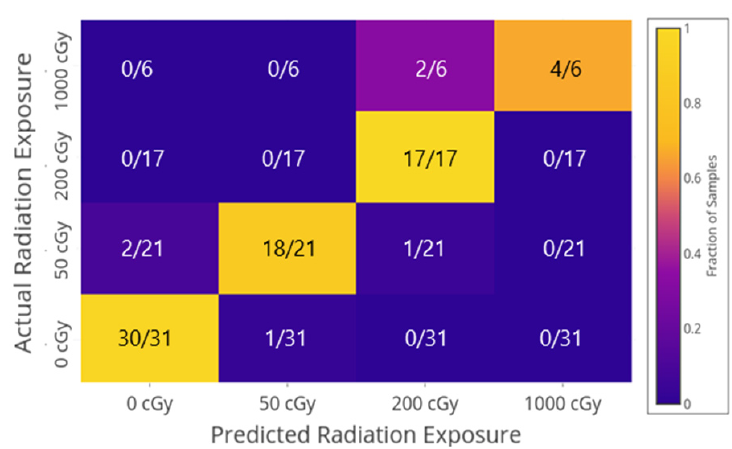
Figure 5. Confusion matrix for murine signature: Phlda3 , Bax , Cdkn1a , Cct3 , Tfam , Pold1 , Cd72 , Cd79b , Ei24 , Galt , Eif2ak4 , Ms4a1 , Ccng1 , Glipr2 , Gga2 , Sh3bp5 , Hexb , Gcdh , Pou2af1 , Swap70 , Apex1 , Ptpn1 , Mdm2 , Tpst1 , Ly6e , Sdcbp , Lcn2 , Suclg2 . Numerators represent the number of samples in each category while denominators represent the total number of samples that were irradiated at a given exposure level (i.e. is the sum of the number of samples in each row).